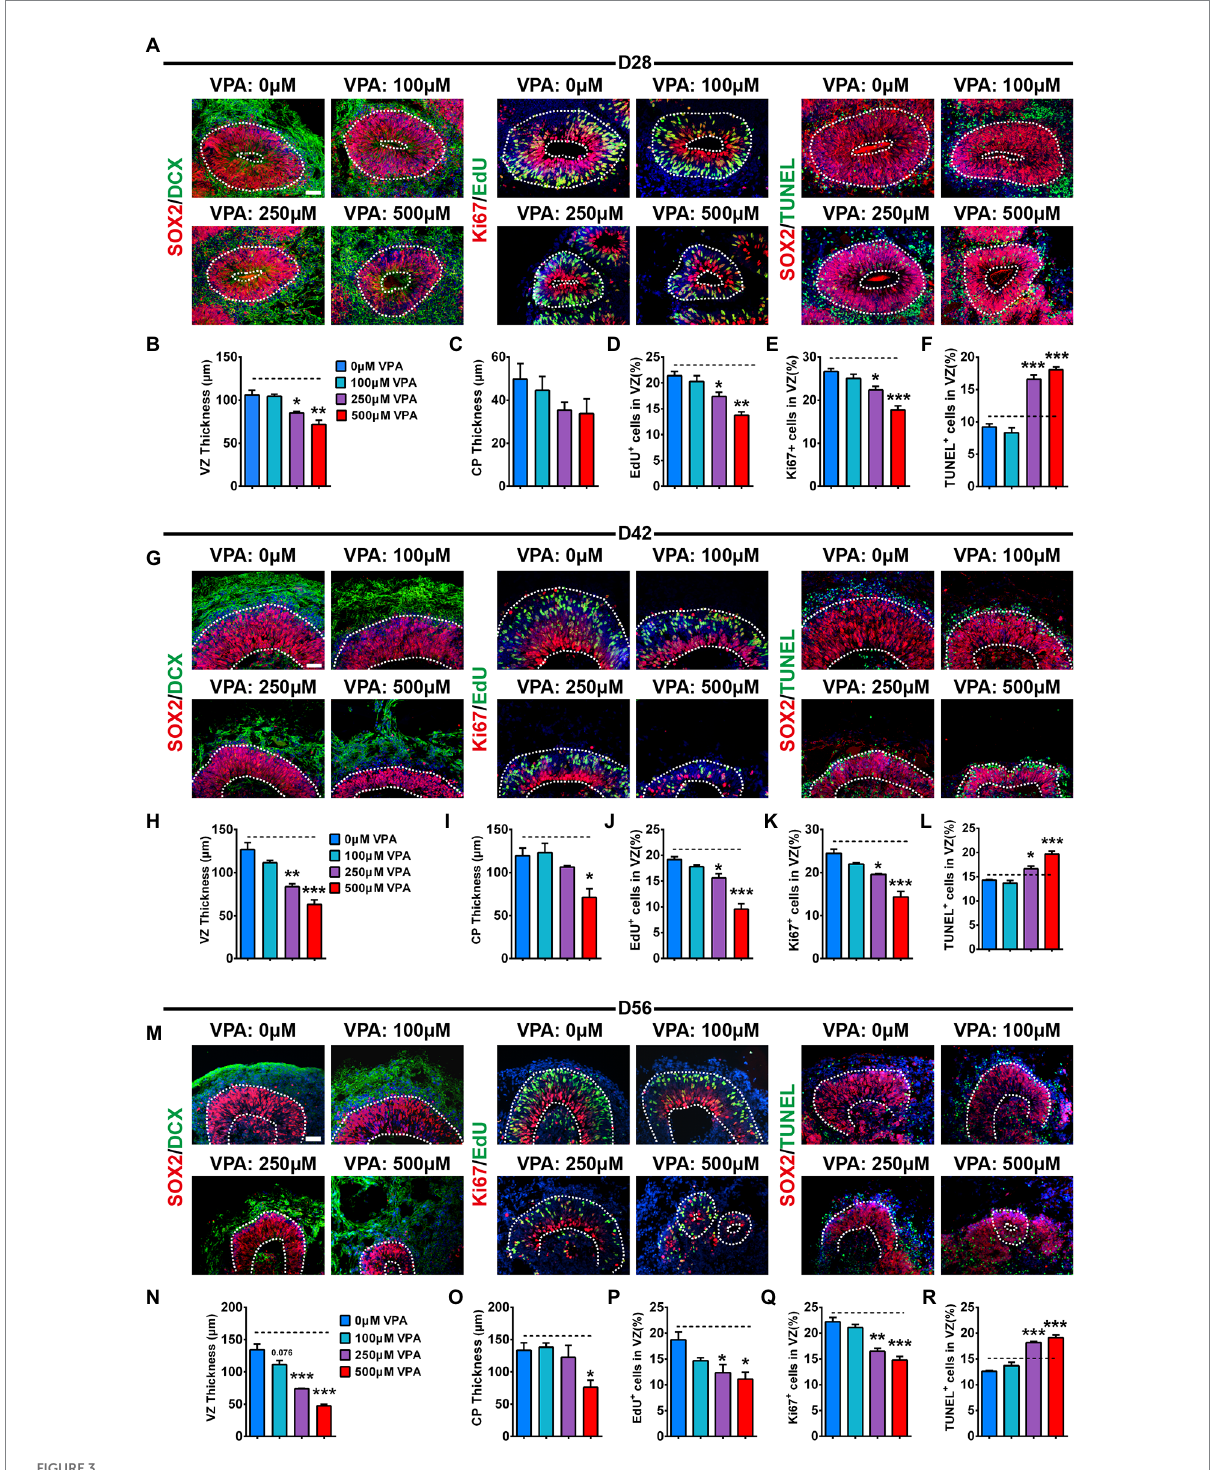
FIGURE 3 VPA exposure decreased proliferation and expansion of NPCs in human dorsal forebrain organoids. Immunostaining for SOX2 (red) and DCX (green), EdU (green) and ki67 (red), SOX2 (red) and TUNEL (green) of days 28 (A) , 42 (G) , and 56 (M) organoids ( n = 3 organoids each). Quantification of the SOX2 + VZ thickness (B,H,N) and DCX + CP thickness (C,I,O) of organoids at days 28 (B,C) , 42 (H,I) , and 56 (N,O) . Quantification of the percentage of EdU + (D,J,P) and Ki67 + (E,K,Q) cells in VZ-like regions of organoids at days 28 (D,E) , 42 (J,K) , and 56 (P,Q) . (H) Quantification of the ratio of TUNEL + cells in VZ-like regions of organoids at days 28 (F) , 42 (L) , and 56 (R) . White dotted lines mark SOX2 + VZ, and DCX + CP-like areas. Scale bars, 50 μ m. * p > 0.05, ** p > 0.01, *** p >